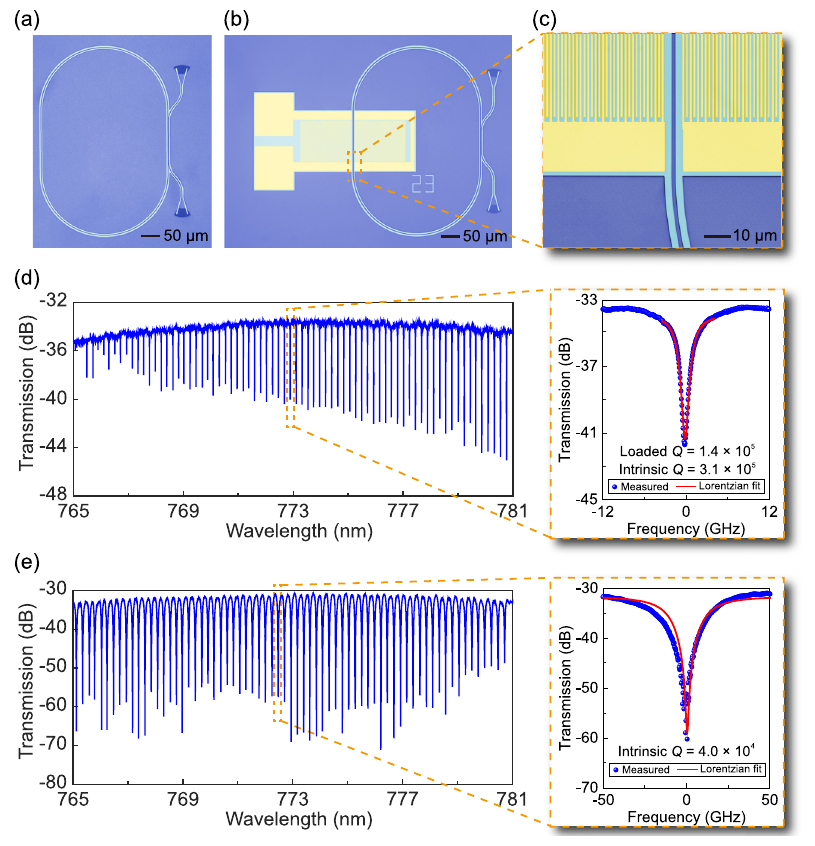
Figure 2: (a, b) Optical microscope image of the fabricated device without (a) and with (b) IDTs. (c) Close-up view of the acousto- optic modulation region. (d, e) Measured optical transmission spectrum (left) and zoomed-in spectrum near 773 nm (right) of the racetrack microcavity without (d) and with (e) IDTs. The blue dots represent the measured data and the red line is the cor- responding Lorentzian fi